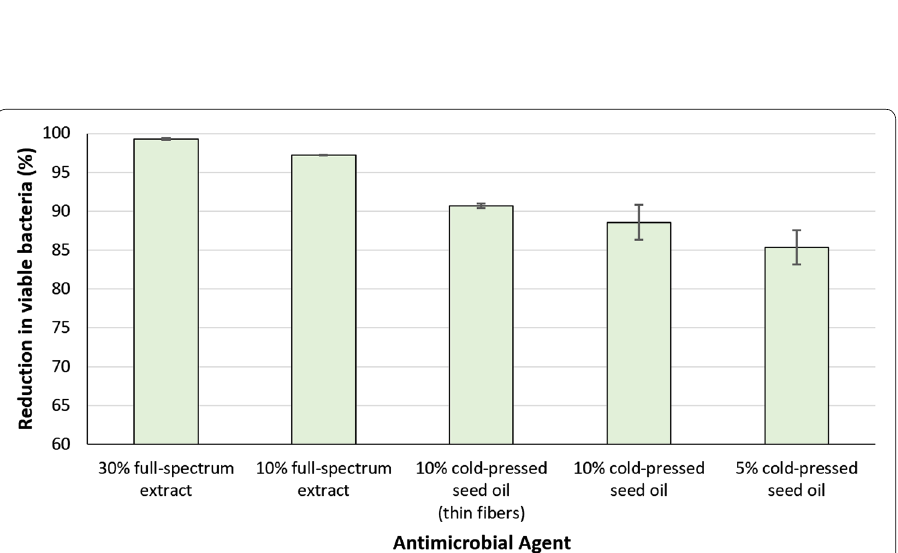
Fig. 5 Percent reduction of viable S. aureus recovered from foil‑backed electrospun acetate nanofibers containing hemp additives. The amount of viable S. aureus recovered from nanofiber samples containing hemp‑derived extract or oil, as compared to acetate‑only nanofiber samples, was decreased in all samples after a 4 h incubation at 37 °C. Each bar represents three independent trials, except for the 10% full‑spectrum hemp extract sample, which was generated from four trials. Error bars represent standard error of the mean for all trials of each